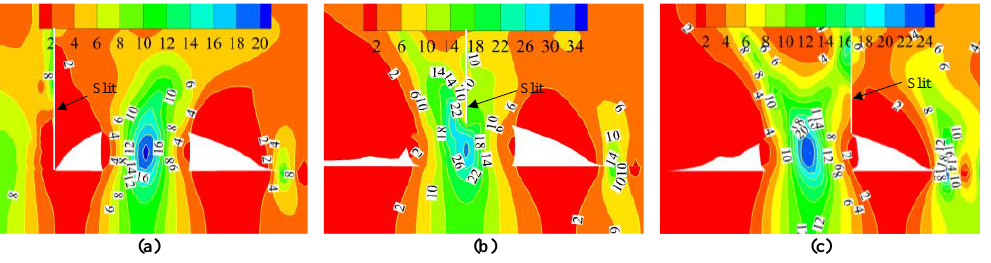
Figure 9. Nephogram of vertical stress distribution of surrounding rock at different top cutting po- sitions: ( a ) working face side; ( b ) above coal pillar; ( c ) gob side.